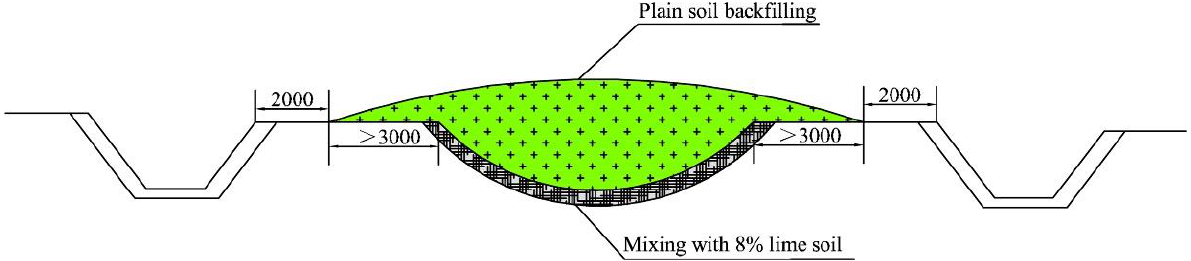
Figure 7. Schematic diagram of surface pit